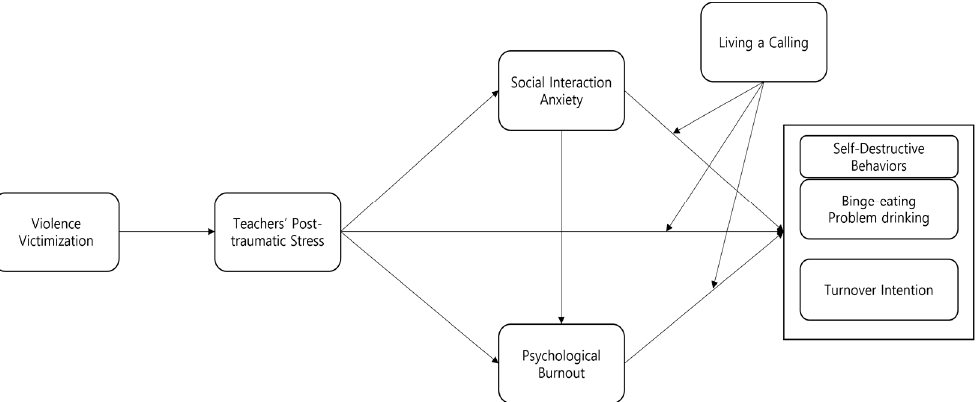
Figure 1. Study model.